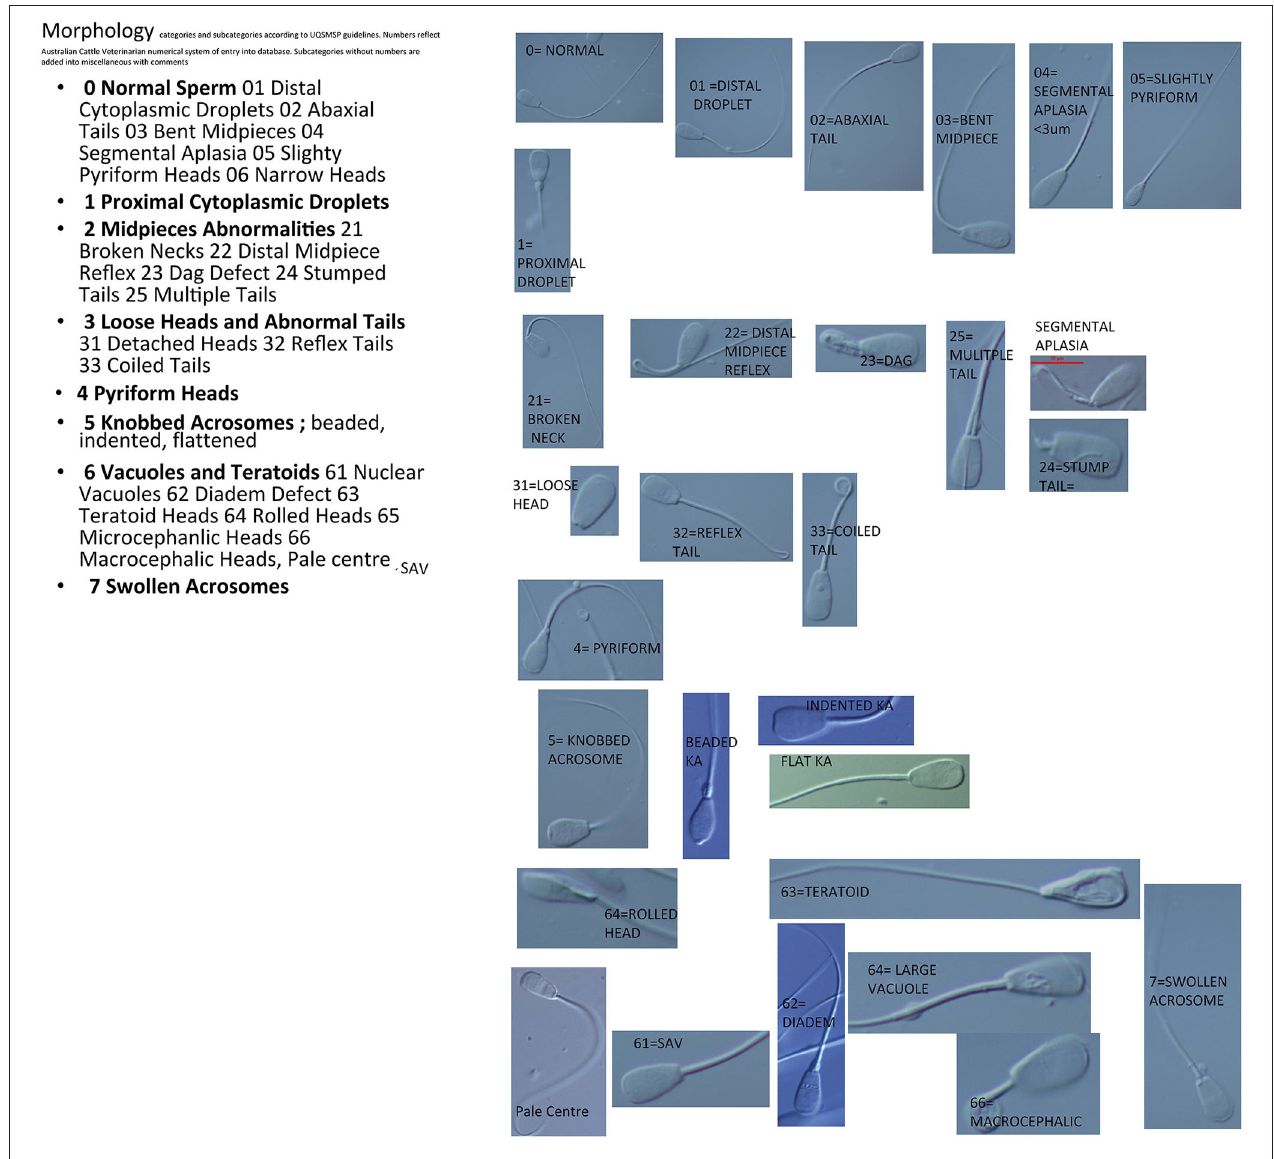
FIGURE 1 | Images of sperm defects as categorized for the